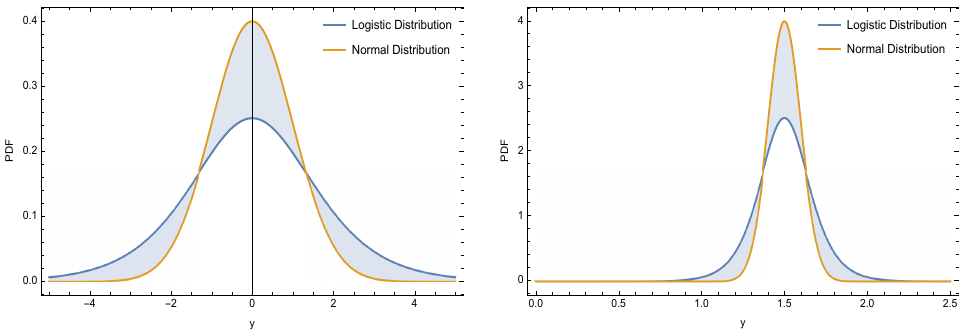
Figure 1. The comparison of normal and logistic PDFs for the parameters µ = 0, σ = 1 in left and µ = 1.5, σ = 0.1, in right